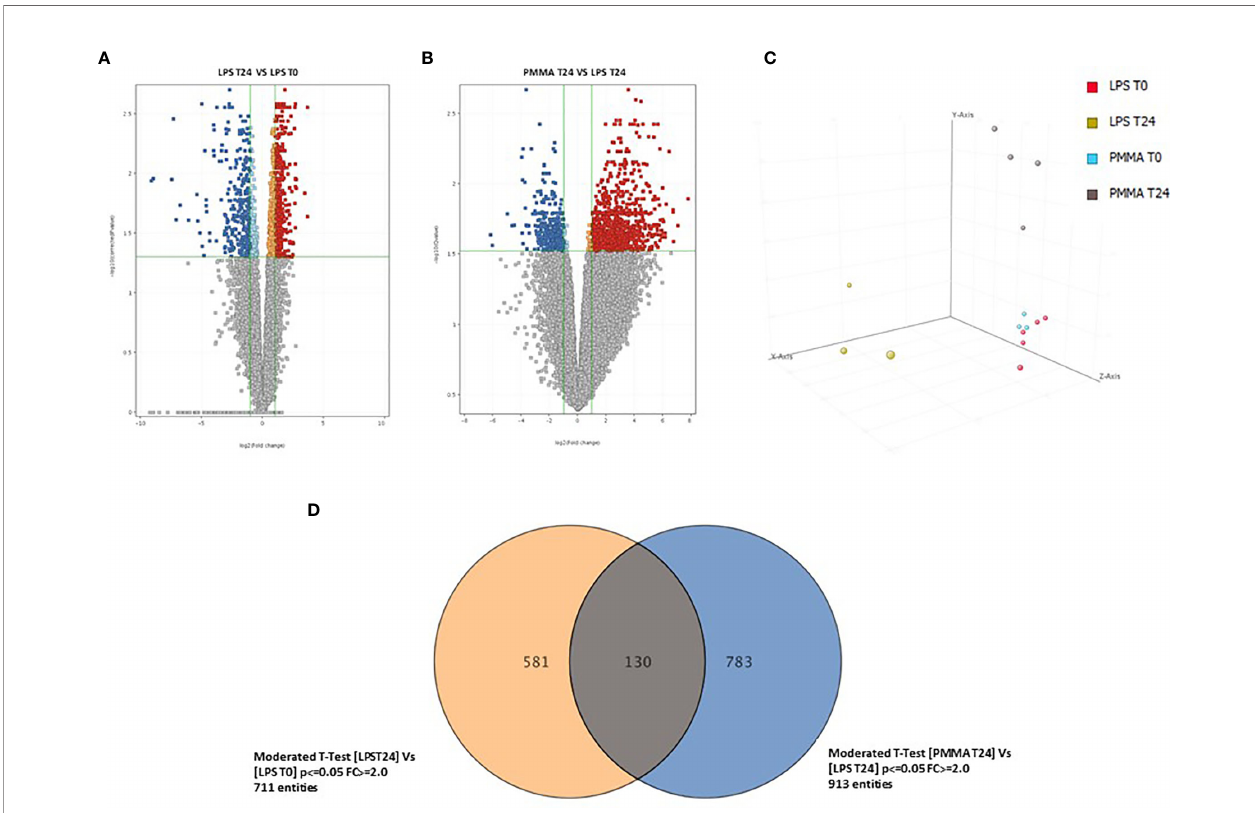
FIGURE 6 | Comparison of the whole-genome gene expression pro fi les of swine PBMC. (A) Volcano plot show 711 genes signi fi cantly modulated with a FDR < 0.05 and a FC > 2; 310 genes were upregulated and 401 genes were downregulated (LPS 24 VS LPS T0). (B) Volcano plot show 913 genes signi fi cantly modulated with an FDR < 0.05 and a FC > 2; 640 genes were upregulated and 273 genes were downregulated (PMMA T24 VS LPS T24). (C) Principal component analysis 3- D diagram showed different spatial distribution of the LPS T24h and PMMA T24h pigs from the healthy cohort (LPS T0 and PMMA T0). (D) Venn diagram showing shared and speci fi c genes for LPS T24 and PMMA group in swine